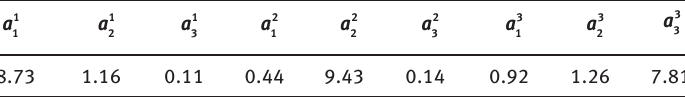
Table 1. Coefficients of the Matrix A ( × 10 –1